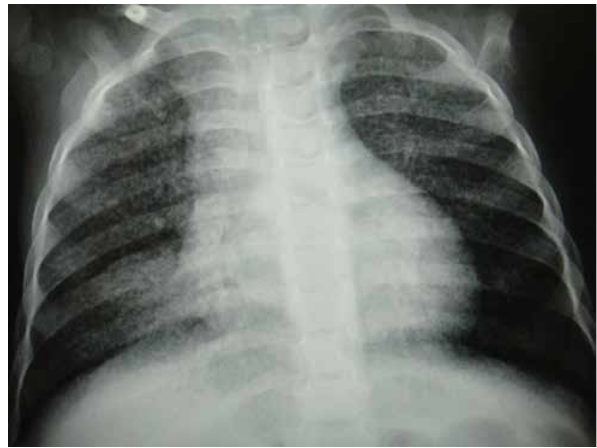
Figure 2: Chest radiography revealed a typical miliary reticulo- nodular